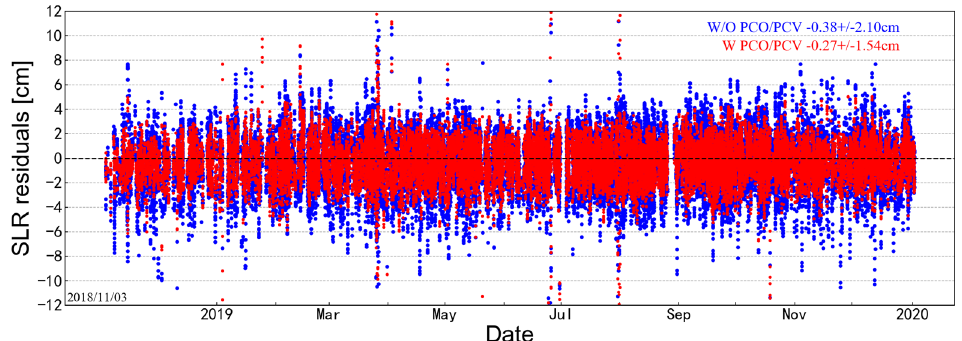
Figure 9. SLR residuals for HY-2B precise orbit determination using the nominal phase center (blue dot) and PCO/PCV correction (red dot) over a 14-month period.